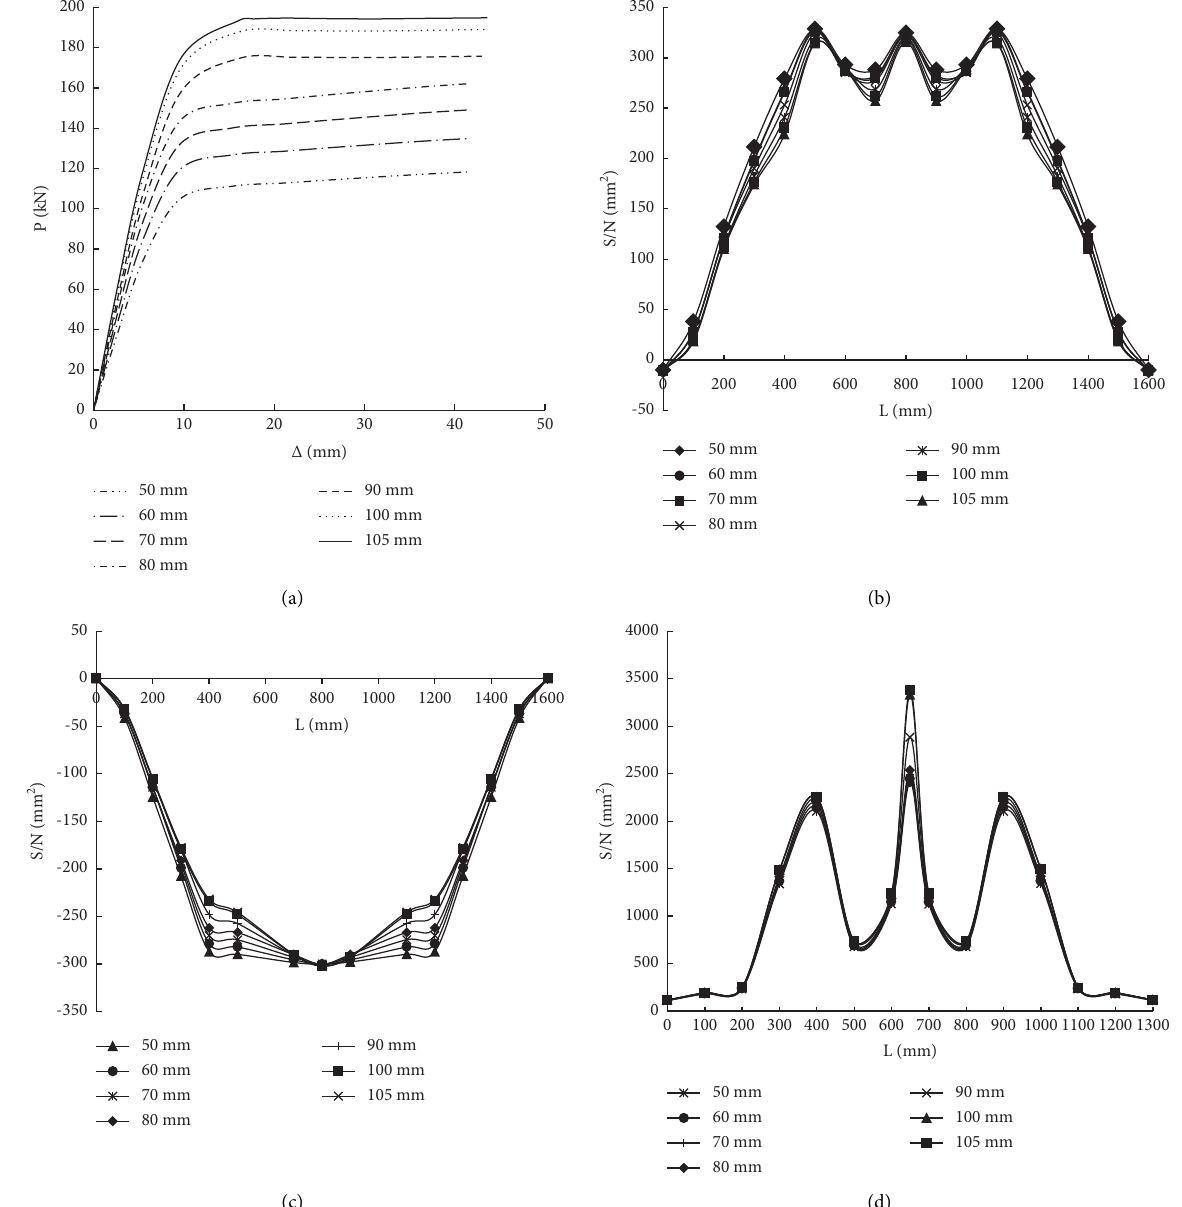
Figure 15: Effect of flange width. (a) Load and deflection. (b) Stress along steel beam length. (c) Stress along steel beam width. (d) Stress along CFRP sheet’s